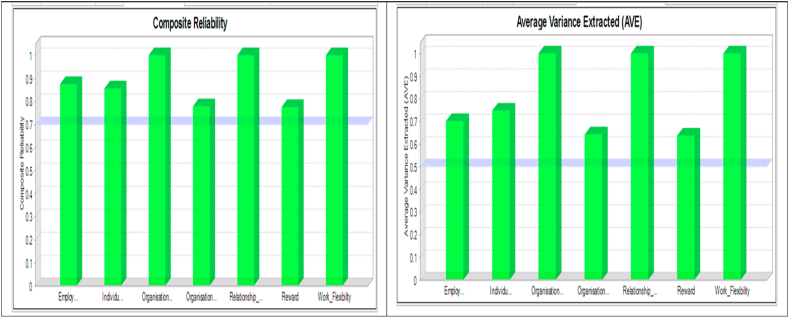
Composite reliability and average variance extracted.